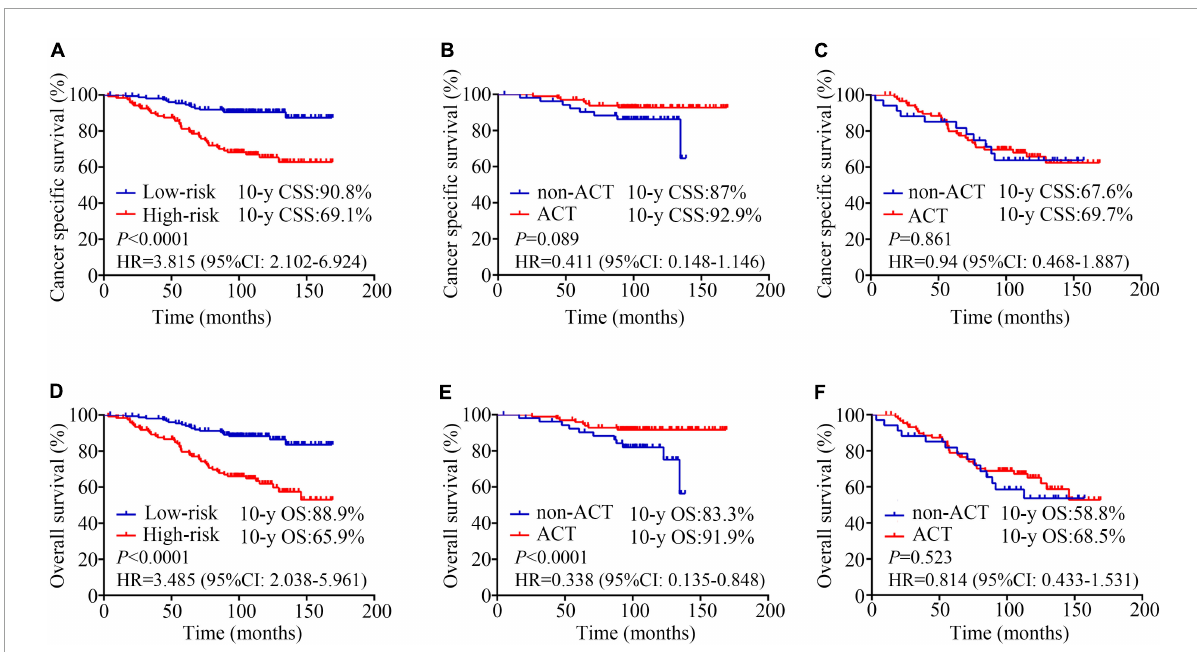
FIGURE3 Kaplan-Meier analysis estimates. Cancer specific survival according to (A) risk stratifications (low-risk vs. high-risk, 10-year CSS: 69.1% vs. 90.8%, HR = 3.815, 95%CI: 2.102–6.924, P < 0.0001); (B) adjuvant chemotherapy (ACT) for low-risk patients (non-ACT vs. ACT, 10-year CSS: 92.9% vs. 87%, HR = 0.411, 95% CI: 0.148–1.146, P = 0.089); (C) adjuvant chemotherapy (ACT) for high-risk patients (non-ACT vs. ACT, 10-year CSS: 67.6% vs. 69.7%, HR = 0.94, 95% CI: 0.468–1.887, P = 0.861); Overall survival according to (D) risk stratifications (low-risk vs. high-risk, 10-year OS: 65.9% vs. 88.9%, HR = 3.485, 95%CI: 2.038–5.961, P < 0.0001); (E) adjuvant chemotherapy (ACT) for low-risk patients (non-ACT vs. ACT, 10-year OS: 91.9% vs. 83.3%, HR = 0.338, 95% CI: 0.135–0.848, P < 0.0001); (F) adjuvant chemotherapy (ACT) for high-risk patients (non-ACT vs. ACT, 10-year OS: 58.8% vs. 68.5%, HR = 0.814, 95% CI: 0.433–1.531, P =